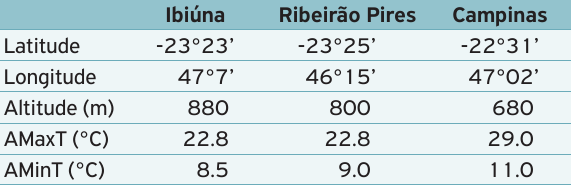
Table 1. Latitude, longitude, altitude, average maximum temperature and average minimum temperature of local of